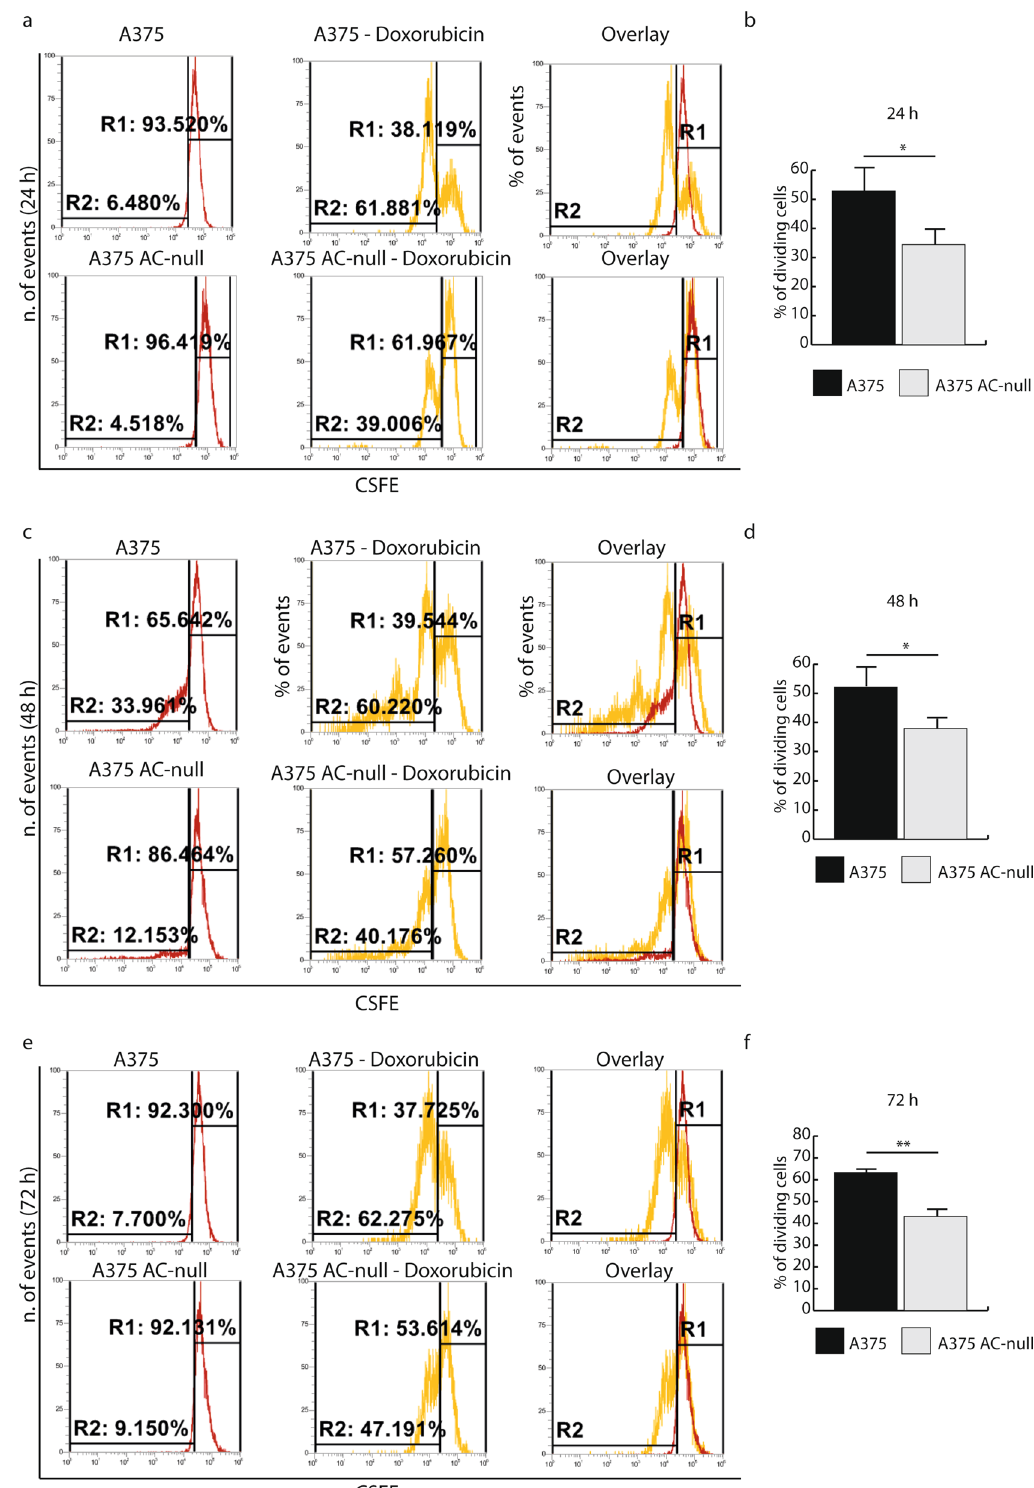
Figure 2. Proliferation recovery assay on A375 and A375 AC-null cells after doxorubicin administration. ( a ) CFSE decay assay performed 24 h after 50 nM doxorubicin treatment. ( b ) Statistical analysis of CFSE assay performed 24 h after 50 nM doxorubicin treatment. ( c ) CFSE decay assay performed 48 h after 50 nM doxorubicin treatment. ( d ) Statistical analysis of CFSE assay performed 48 h after 50 nM doxorubicin treatment. ( e ) CFSE decay assay performed 72 h after 50 nM doxorubicin treatment. ( f ) Statistical analysis of CFSE assay performed 72 h after 50 nM doxorubicin treatment. The CSFE statistical analyses were performed using Student’s t test (* p < 0.05, ** p < 0.01, *** p < 0.001). Data are expressed as mean ± SD. Experiments were performed in three independent experiments with three technical replicates